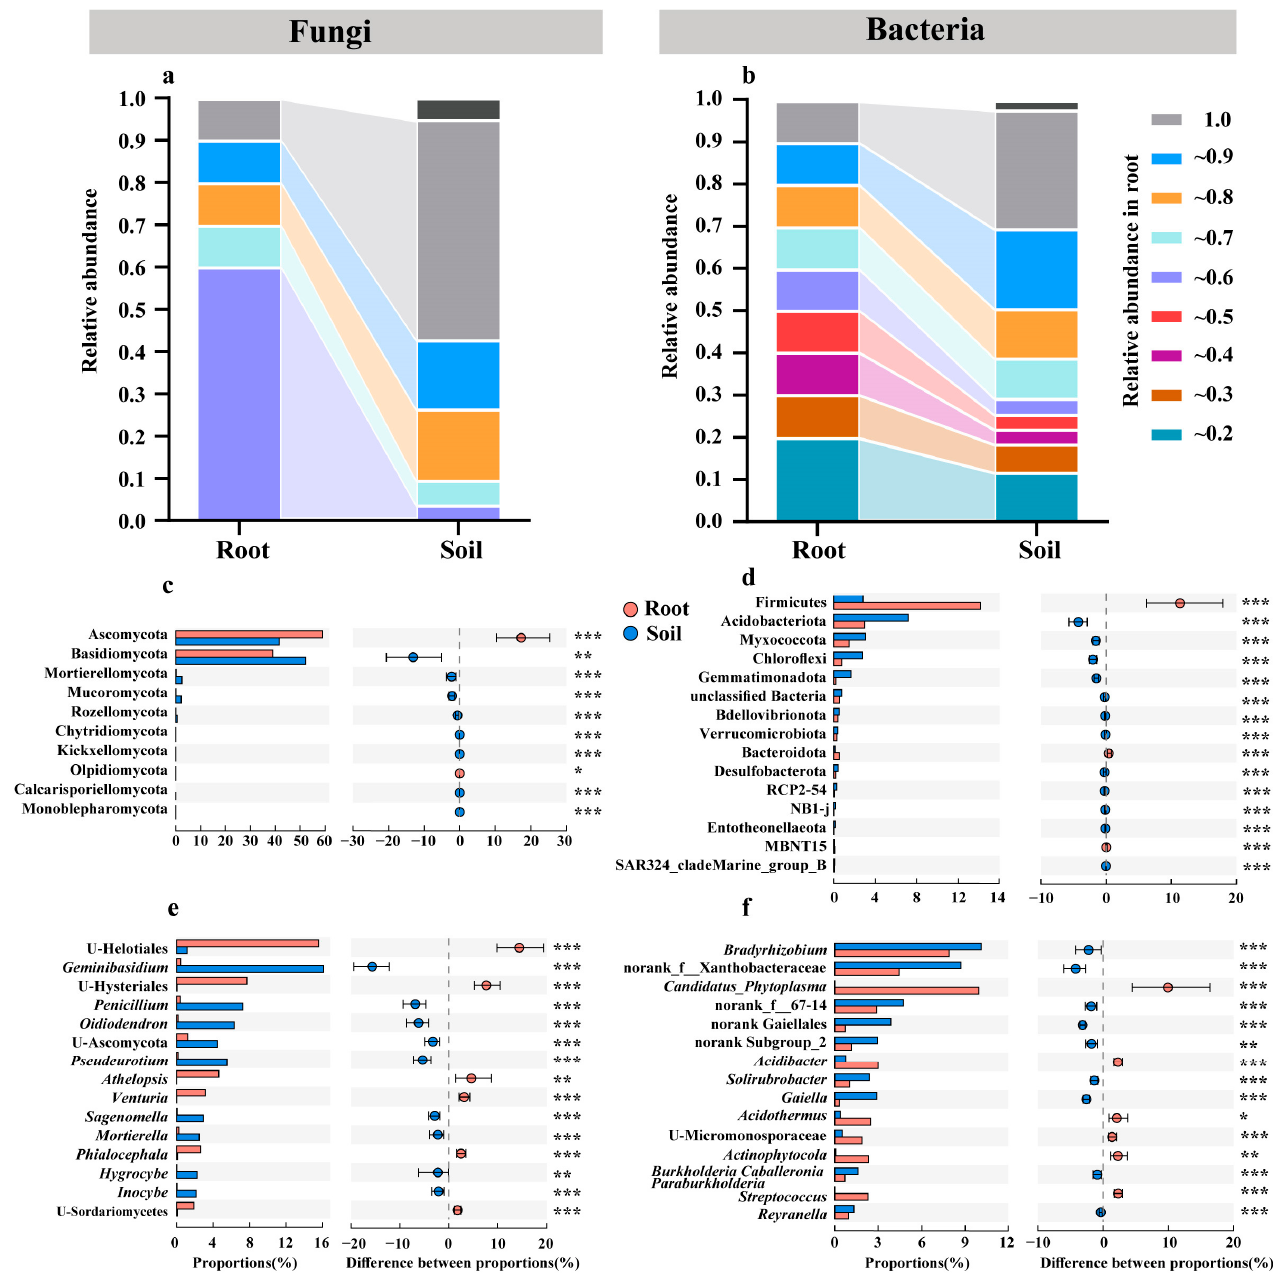
Figure 8. Differentiation of microbial communities in rhizosphere soil and roots. The proportion of root endophytic fungi ( a ) and bacteria ( b ) enriched in rhizosphere soil. The different groups between rhizosphere soil and roots at the phylum ( c , d ) and genus ( e , f ) levels. Mann–Whitney U tests were used to evaluate differences in the abundance of rhizosphere soil and roots. Significant difference: * p ≤ 0.05, ** p ≤ 0.01, *** p ≤ 0.001. “U-” represents “unclassified-”.